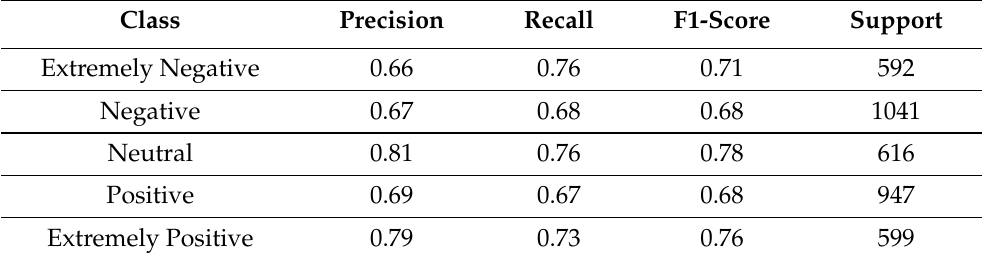
Table 5. Evaluation scores per class for the BERT